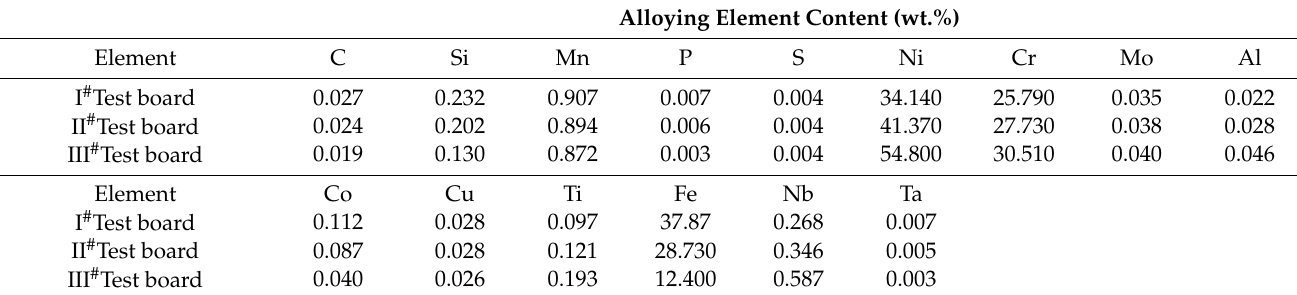
Table 7. Test results of alloy composition. Alloying Element Content